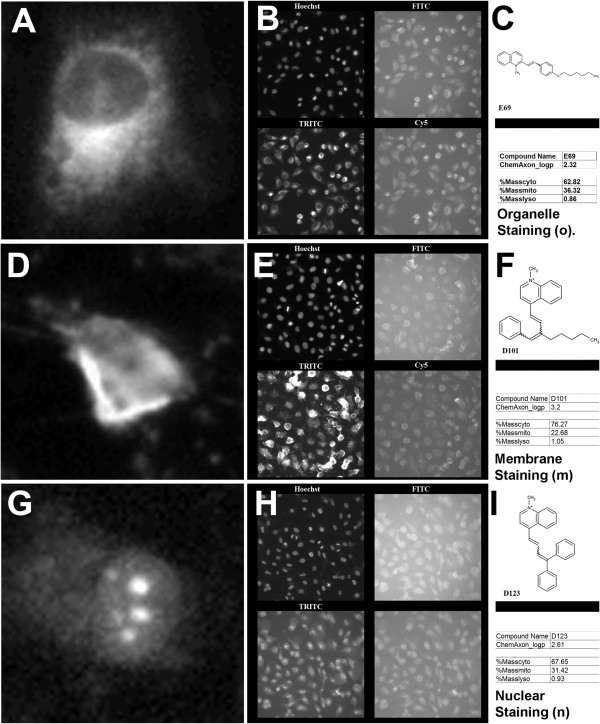
Visual inspection revealed three distinct cell-associated staining patterns exhibited by the styryl probes. A) Zoom in image of a single cell showing typical staining pattern of organelles. Note the nucleus in the middle is dark, and the surrounding cytoplasm is bright with local hot spots indicative of organelle staining. B) Hoechst (top left), FITC (top right), TRITC (bottom left) and Cy5 (bottom right) images corresponding to organelle staining probe. C) Chemical structure, logP and predicted cellular distribution data of the probe visualized in A and B. D) Zoom in image of a single cell showing typical staining pattern associated with cellular membranes. Note the probe distribution in the cytoplasm appears diffuse, with the brightest signal generally present at the cell periphery. E) Hoechst (top left), FITC (top right), TRITC (bottom left) and Cy5 (bottom right) images corresponding to membrane staining probe. F) Chemical structure, logP and predicted cellular distribution data of the probe visualized in D and E. G) Zoom in image of a single cell showing typical staining pattern of nuclear staining probe. Note the probe’s optical signal is brightest in the cell nucleus, with nucleolar labeling. H) Hoechst (top left), FITC (top right), TRITC (bottom left) and Cy5 (bottom right) images corresponding to nuclear staining probe. I) Chemical structure, logP and predicted cellular distribution data of the probe visualized in G and H.